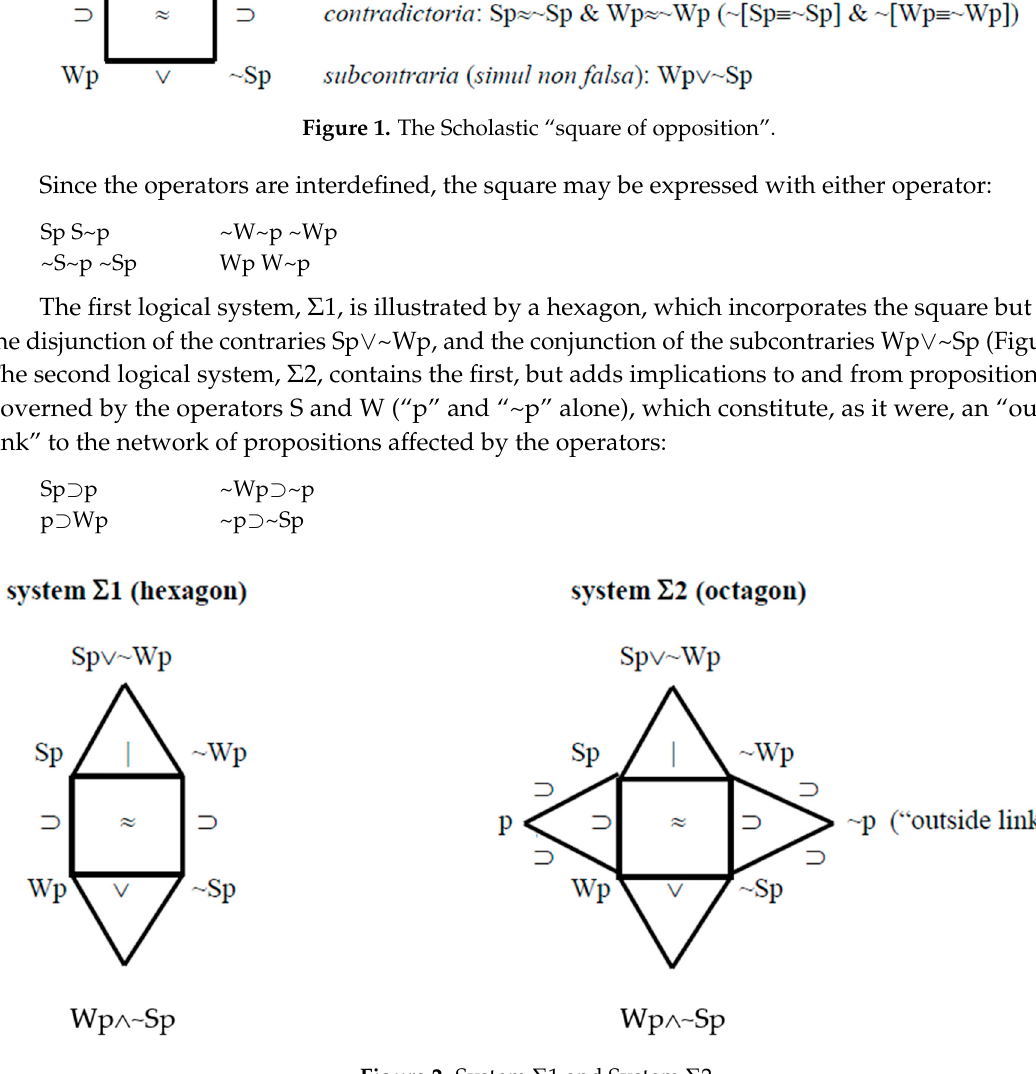
Figure 2. System Σ 1 and System Σ 2.